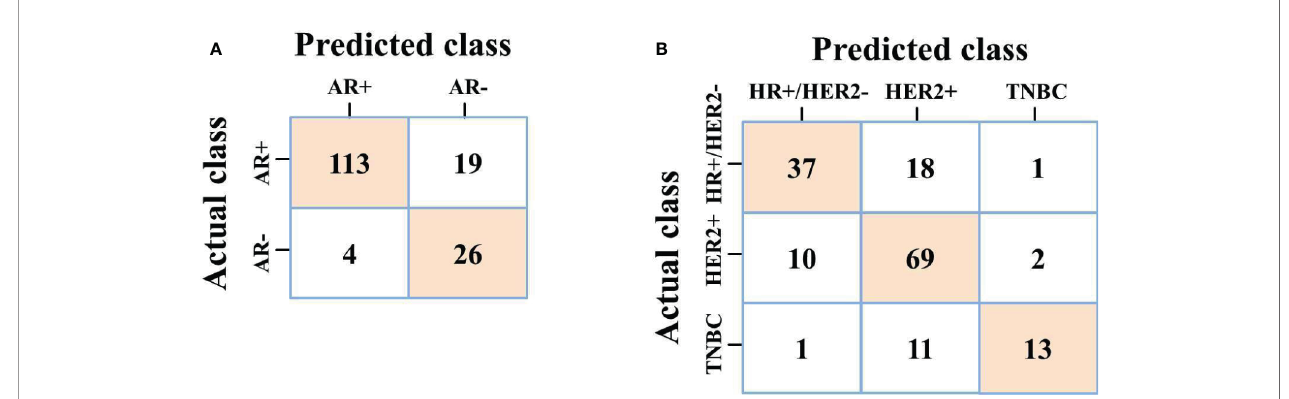
FIGURE 7 | (A) Confusion matrix of MLP on predicting AR expression; (B) Confusion matrix of MLP on predicting